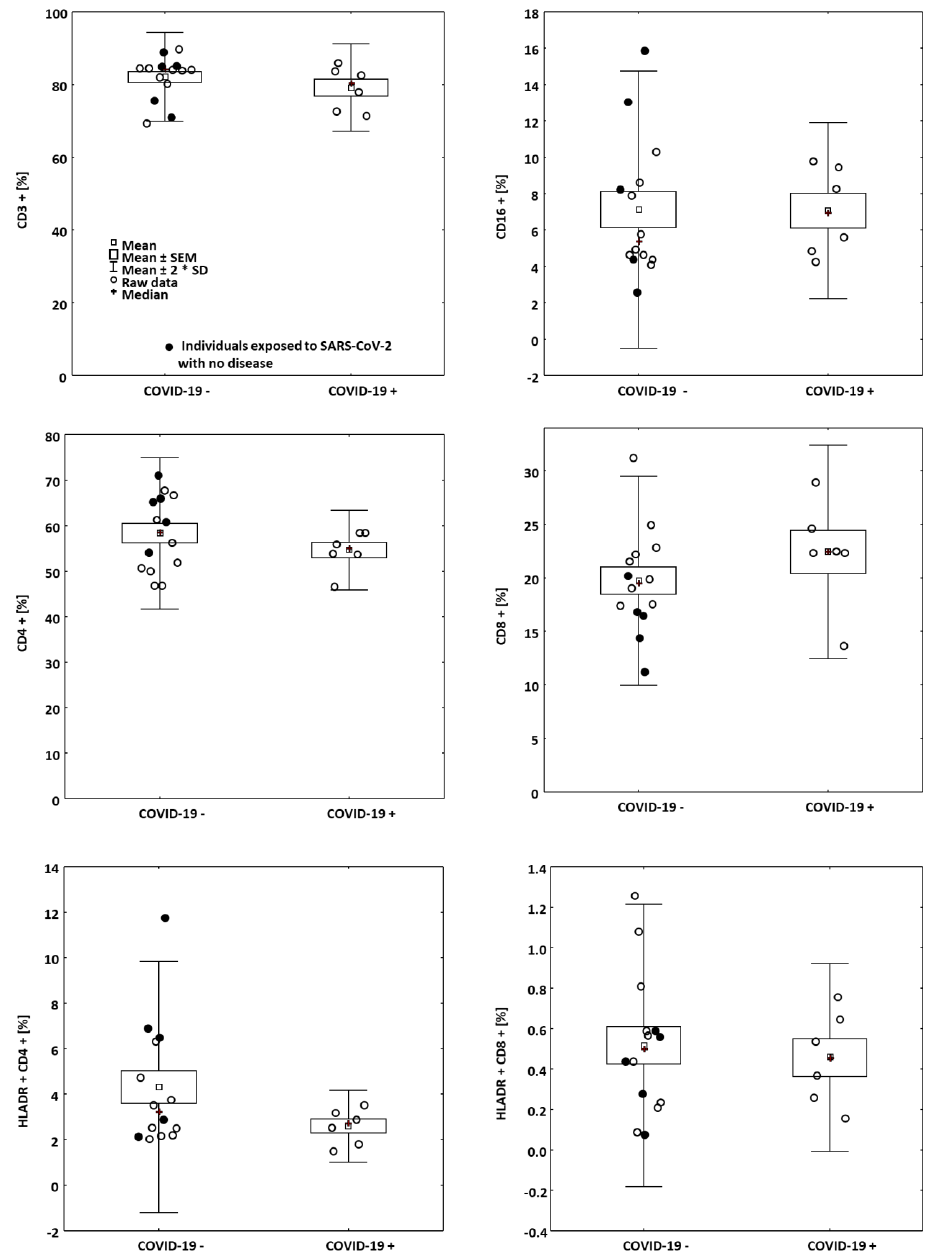
Figure 3. Proportions of lymphocyte subpopulation in the blood in the patients having and lacking COVID-19 in the past.